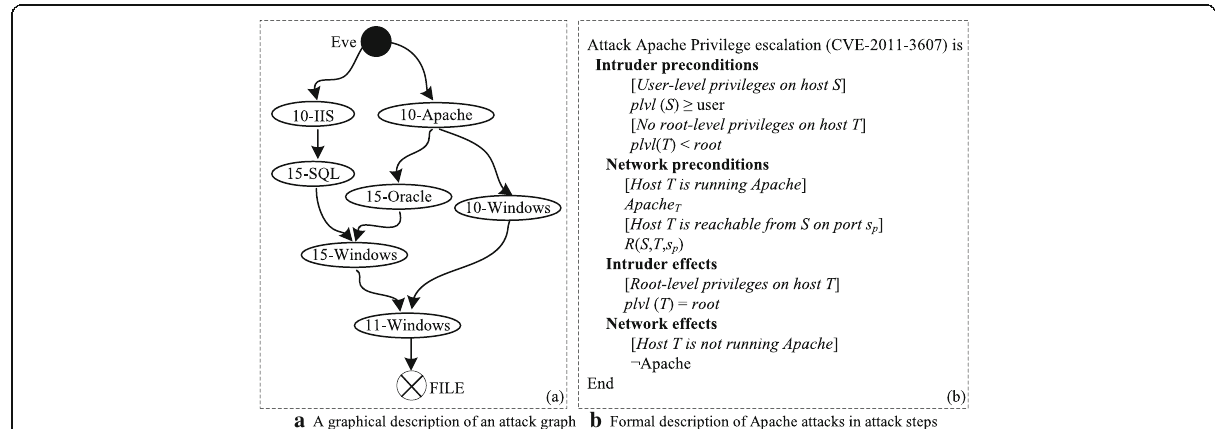
Fig. 7 An attack map for FTP on 11 servers in the experimental network. a A graphical description of an attack graph. b Formal description of Apache attacks in attack